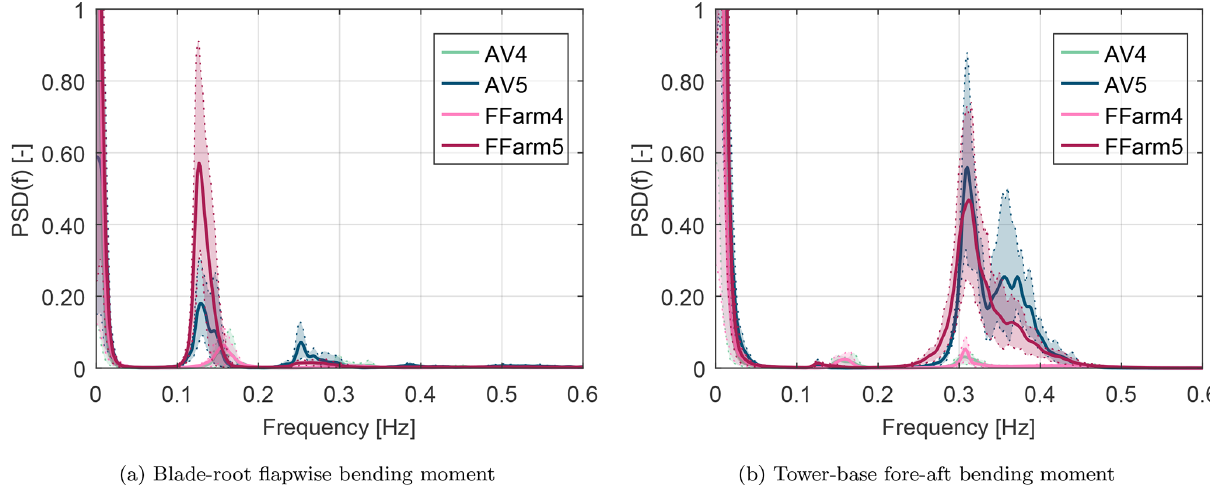
Figure 10. Comparison of power spectral densities (PSDs) between measurements (AV4, AV5) and simulations (FFarm4, FFarm5) for wind speed bin I (wind direction 270.75–273.25 ◦ ). Thick lines show the mean of the PSDs for all considered events. The shaded area indicates the 15th and 85th